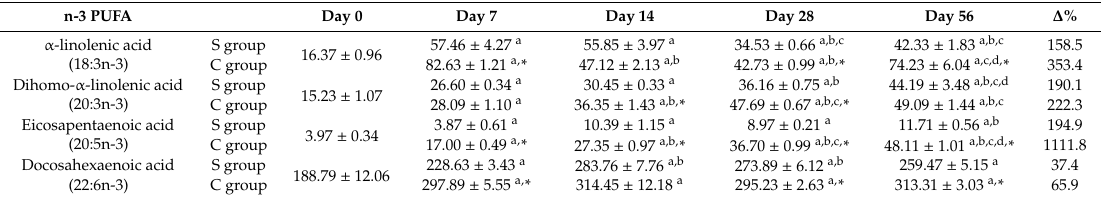
Table 6. Polyunsaturated n-3 fatty acid (n-3 PUFA) composition (mg / 100g of sample) in the livers of mice fed with a diet containing soybean oil (S group) or canola oil (C group) as a lipid source, at 0, 7, 14, 28, or 56 days after starting the